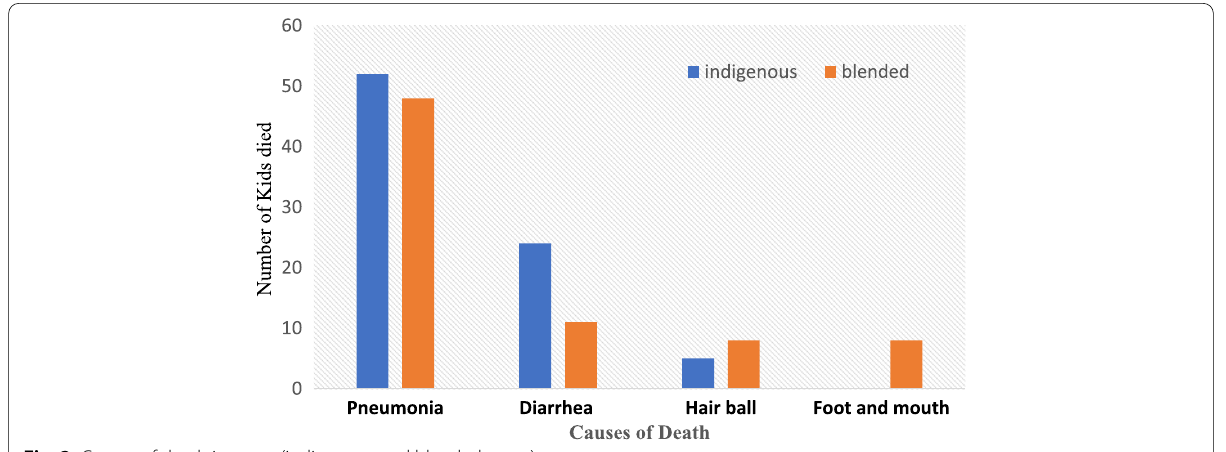
Fig. 2 Causes of death in goats (indigenous and blended goats)